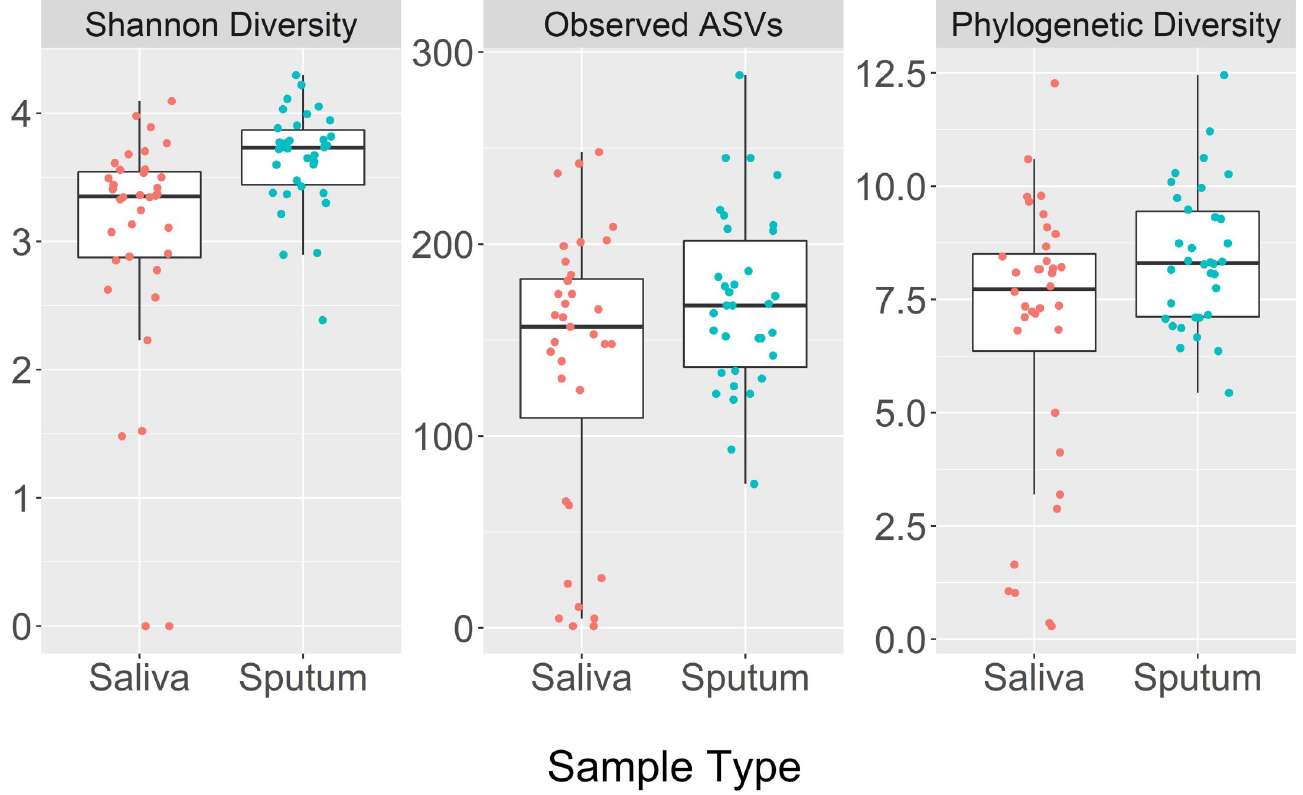
Fig 1. Box plots comparing bacterial alpha diversity indices between sputum and saliva, including Shannon diversity, number of observed amplicon sequence variants (ASVs), and Faith’s phylogenetic diversity.